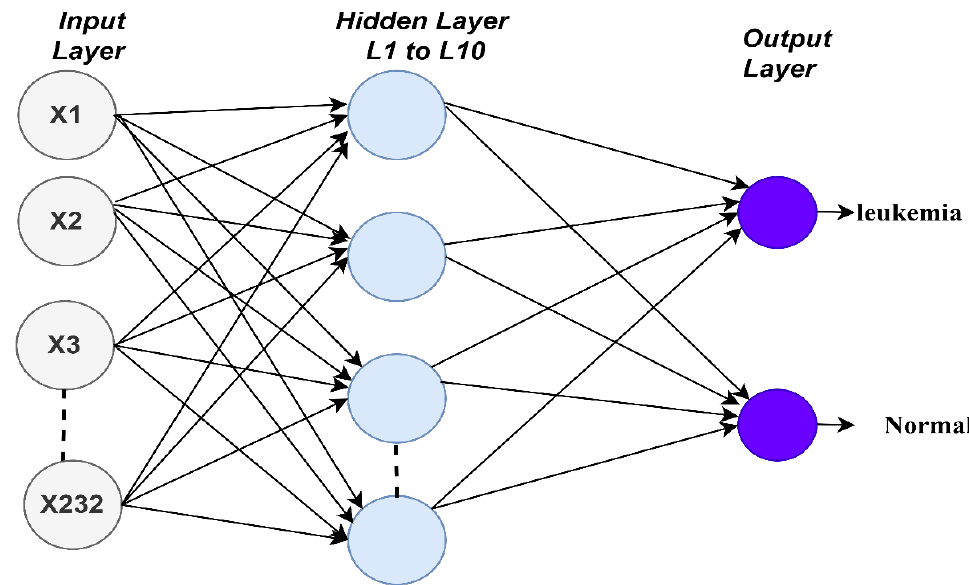
Figure 7. Architecture of the artificial neural network and feed forward neural network classifiers of the ALL-IDB dataset.